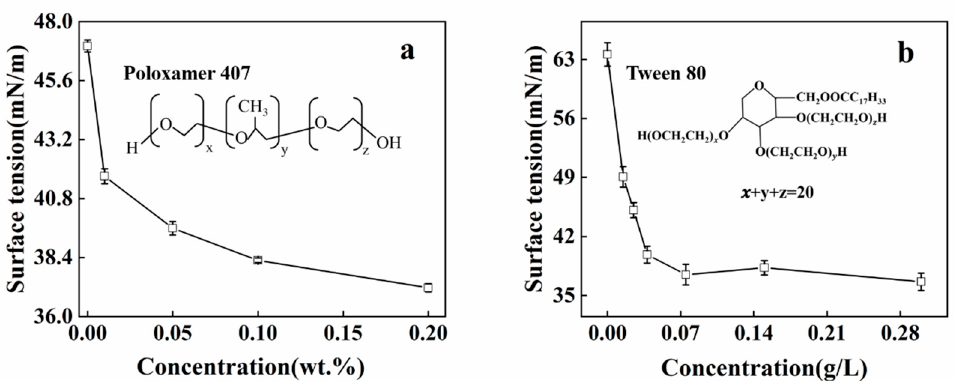
Figure 3. The surface tension of the solution as the function of ( a ) 0.5 wt.% SA solution with different concentrations of poloxamer 407 and ( b ) 1.5 wt.% CaCl 2 and 1 wt.% CMC solution with different Tween 80 concentrations. Inserts show the chemical structures of poloxamer 407 and Tween 80.